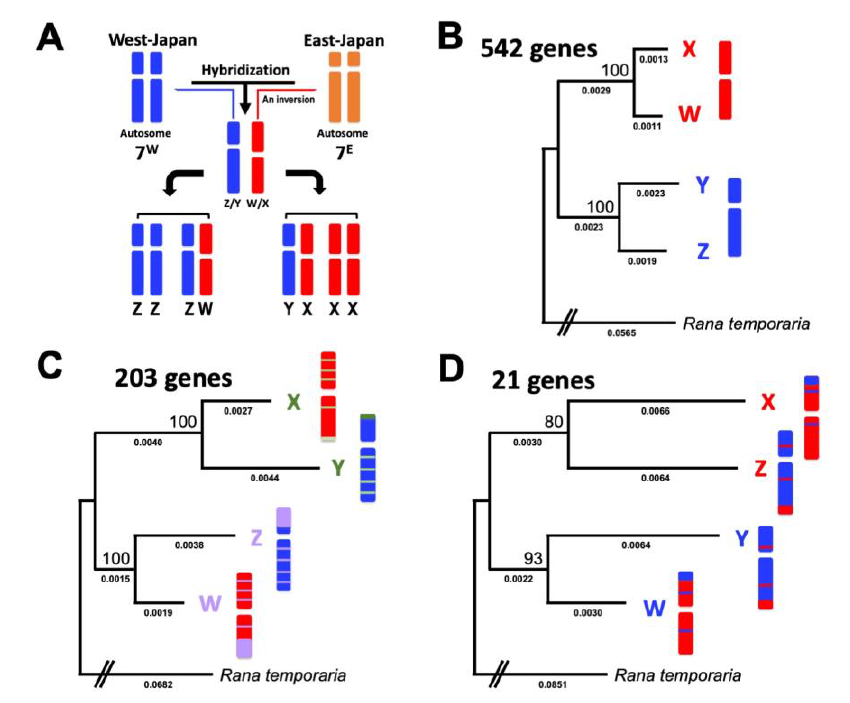
Figure 1. Sex chromosome evolution in Glandirana rugosa and sex-linked gene trees. ( A ) Diagrammatic representation of the sex chromosome evolution in G. rugosa . The XY and ZW sex chromosomes originated from the hybridization between two ancestral type populations of the West-Japan and East-Japan ( G. reliquia ) groups. X and W chromosomes are indicated in red and the homologous autosome 7 of the East-Japan group ( G. reliquia ) in orange, while Y, Z, and homologous autosome 7 of the West-Japan group are indicated in blue. ( B – D ) Phylogenetic trees were constructed by PAML using 542, 203, and 21 sex chromosome-linked genes (free ratio model) from three different clusters, XW/YZ, XY/ZW, and XZ/YW, respectively. The best-fit models of nucleotide substitution were se- lected by the Modeltest-NG. Numbers at each node denote the bootstrap percentage values based on 1000 replicates. Numbers below the branches are the expected mean numbers of nucleotide sub- stitutions per site . Rana temporaria was used as an outgroup. 3.2. Three Clusters of Sex-Linked Genes Based on the topology of the tree of each gene constructed by RaxML-NG, the 766 sex-linked genes were classified into three different clusters: XW/YZ (542 genes), XY/ZW (203 genes), and XZ/YW (21 genes) (Table S1). Then, the concatenated tree of each of the three clusters was constructed by RaxML-NG (Figure 1B – D). The local bootstrap values in the three gene trees were 100, 100, and 80/93, respectively (Figure 1B – D). We then investigated the genomic distributions of the genes belonging to the three clusters on chromosome 9 of R. temporaria , which is orthologous to the sex chromosomes of G. rugosa . The genes of the three clusters were distributed evenly along the chromoso- mal axis, except for one region spanning from 160 to 184 M (out of 0 – 184 M), where 84.6% of the genes of the XY/ZW cluster were concentrated, while 10.8% and 4.6% of the genes of the XW/YZ and XZ/YW clusters, respectively, were concentrated (Figure 2). The se- quence identity between the Z- and W-genes of the XY/ZW cluster in the 160 – 184 M region was 99.87% and was significantly higher than 99.29% in the 0 – 160 M region (Tukey HSD, p < 0.001 in Figure 3C). On the other hand, the sequence identities between the X- and Y- genes were 99.22% and 99.47% in the 0 – 160 M and 160 – 184 M regions, respectively, which were not significantly different from each other (Turkey HSD, p = 0.1274, in Figure 3C). In contrast, the sequence identity between the X- and Y-genes of the XZ/YW cluster was 95.74% in the 160 – 184 M region and significantly lower than 99.32% in the 0 – 160 M region (Tukey HSD, p < 0.001 in Figure 3D).